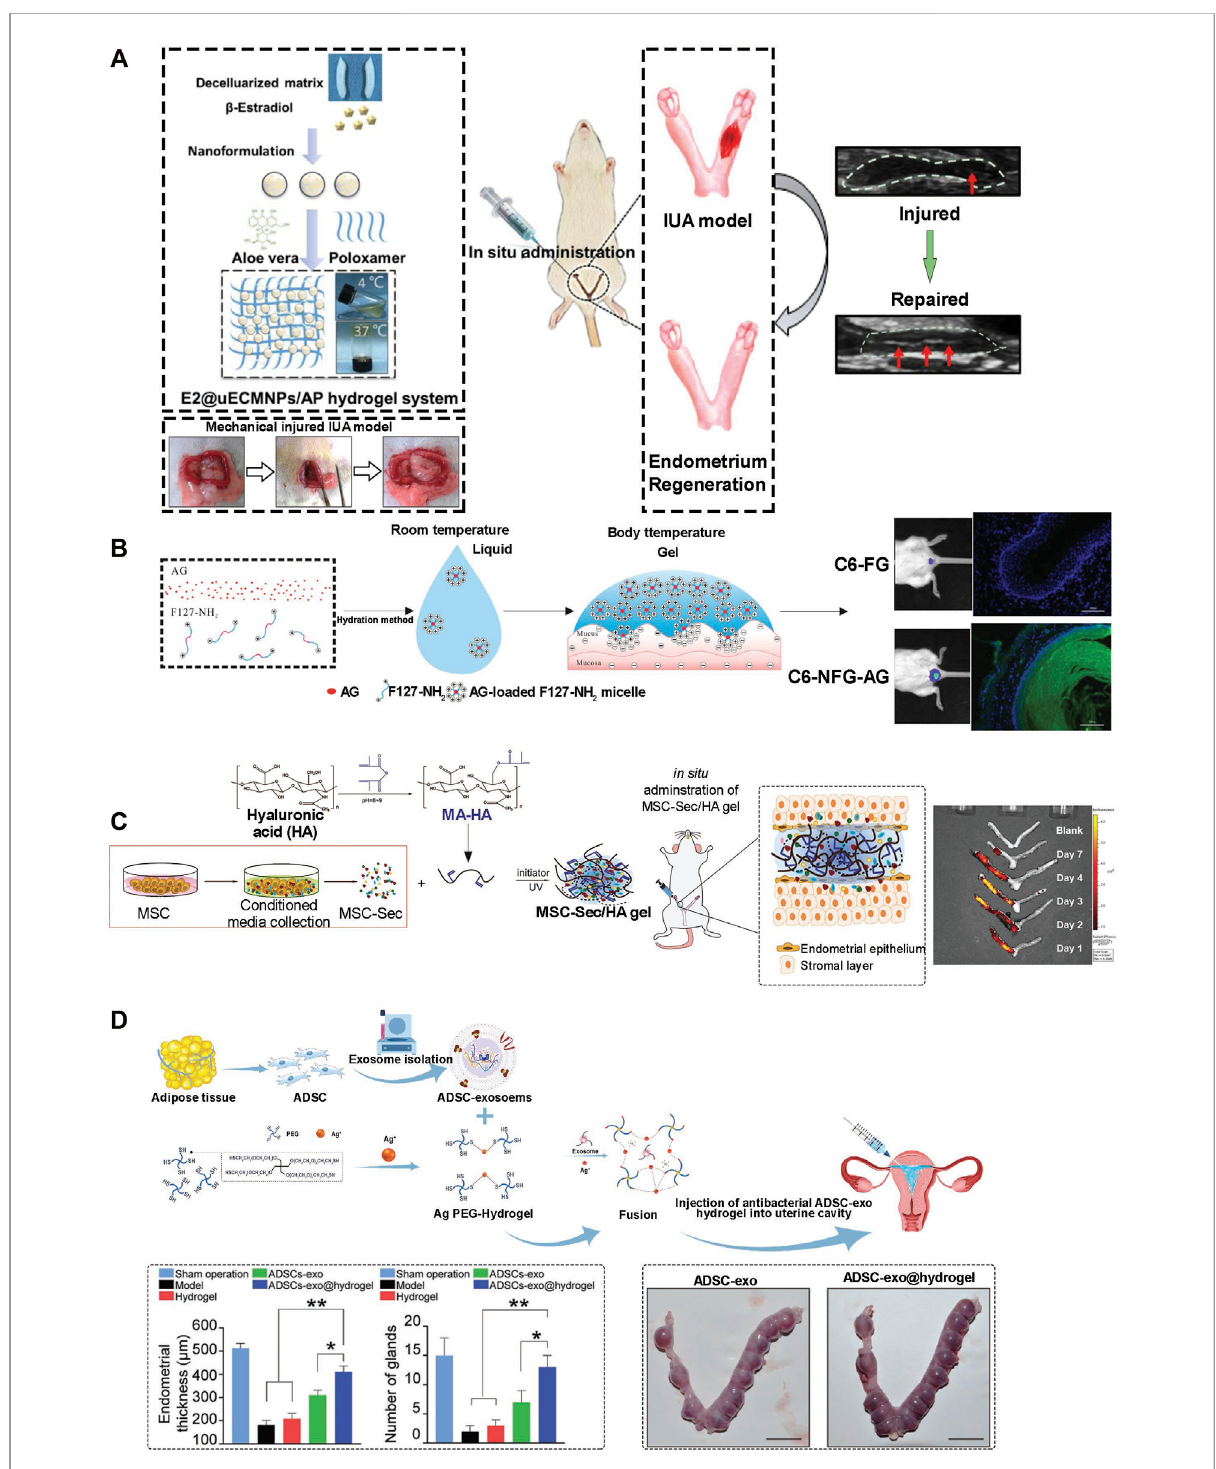
FIGURE 1 Application of hydrogel in endometrium injury. (A) E2@uECMNPs/AP hydrogel system for B-estradiol. Following establishment of rat intrauterine adhesion (IUA) model, and treatment the theragnostic ultrasound test was employed to compare the images of the injured IUA with or without E2@uECMNPs treatment (Yao et al., 2020). (B) Poloxamer 407 (F127)-based in situ hydrogel for the delivery of acetate gossypol (AG) as a model drug. Intravaginal retention of NFG (acetate gossypol-loaded aminated poloxamer 407-based temperature-sensitive hydrogel) and FG (F127gel)wasevaluated.Photographsand fl uorescencemicroscopyshowedNFGprolongedintravaginalresidence(Cietal.,2017). (C) HA-Hydrogel